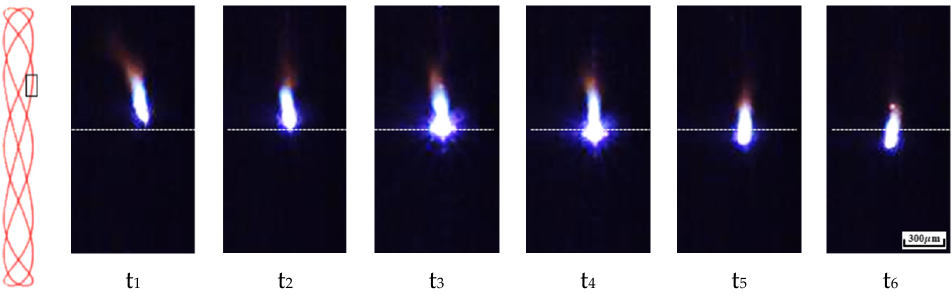
Figure 13. Laser-induced plume/plasma images taken with a high-speed camera in the presence of the paint residue.